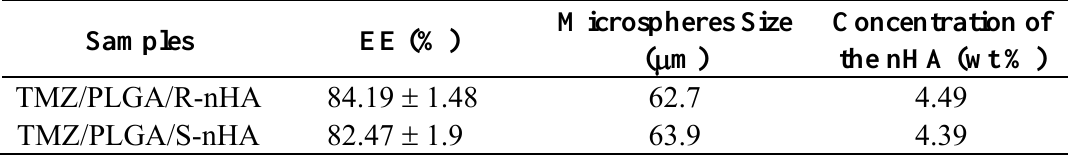
Table 2. Microsphere size distribution, TMZ encapsulation efficacy (EE) and the proportion of the nHA in